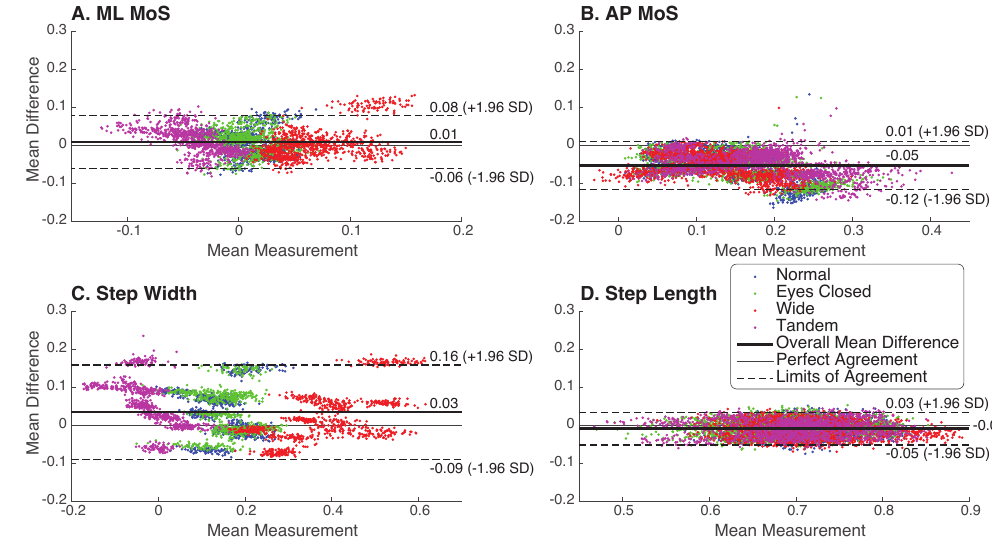
Figure 4. Bland–Altman plots of minimum MoS and step placement measures to compare IMU and Optical results. Mean measurement and mean differences for ( A ) minimum ML MoS, ( B ) minimum AP MoS, ( C ) step width, and ( D ) step length derived from individual strides from all conditions ( N = 10). Each data point represents an individual gait cycle with mean difference defined as IMU values subtracted from Optical values. Strides from all four conditions were included (Normal—blue, Eyes Closed—green, Wide—red, Tandem—magenta). Overall mean difference (thick solid line) and 95% LoA (dashed line) are shown with the perfect agreement line (thin solid line) for